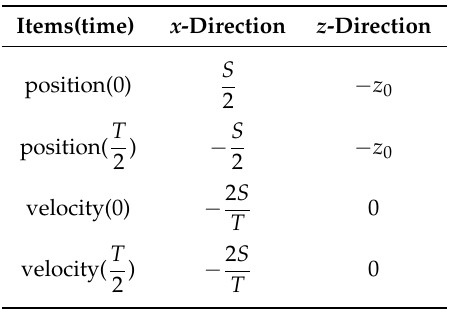
Table 3. The initial and terminated conditions of the stance